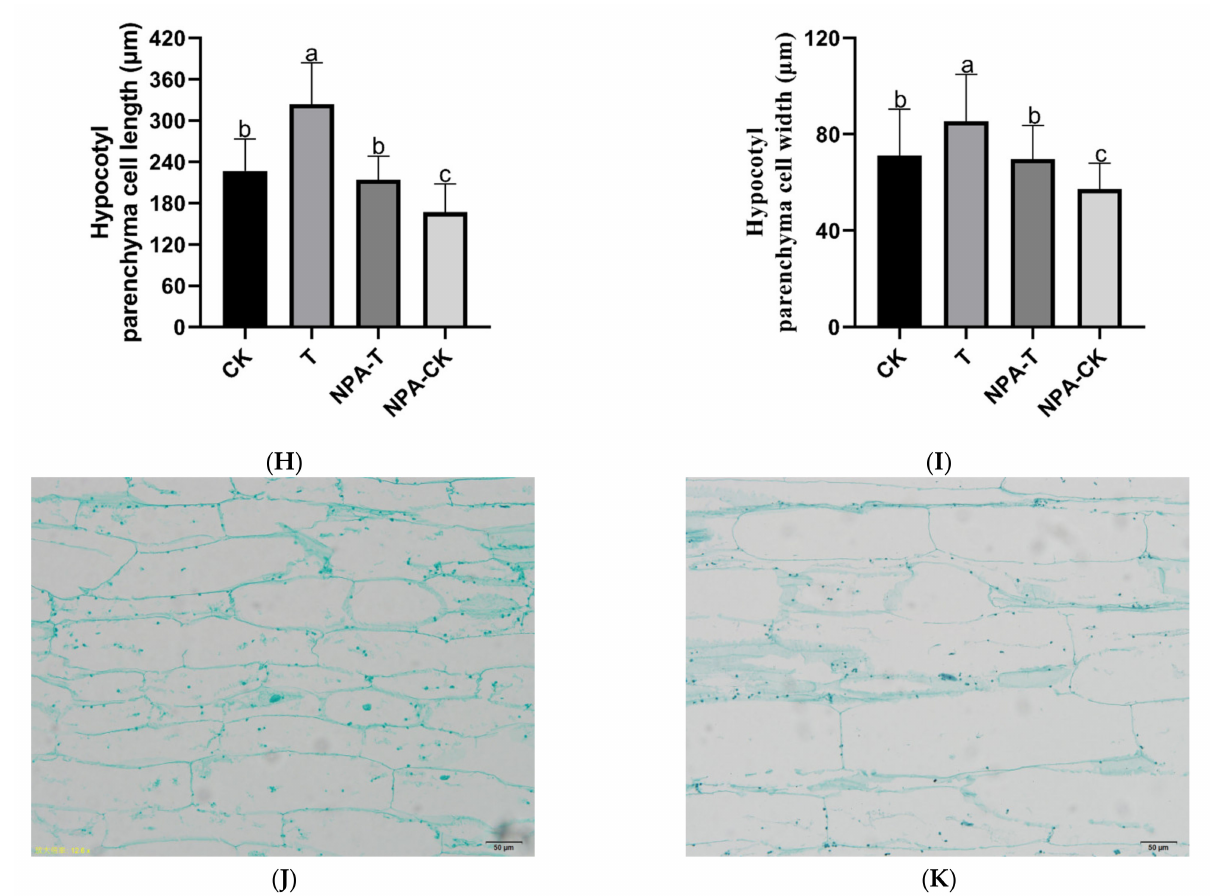
Figure 1. Phenotypic changes in pumpkin seedlings in response to EOD-FR treatment. CK, Control; T, EOD-FR treatment; NPA-T, EOD-FR treatment plus the auxin transport inhibitor NPA; NPA-CK, NPA alone. ( A ) Pumpkin seedlings from different treatments. Hypocotyl length ( B ), stem diameter ( C ), shoot system fresh weight ( D ), root fresh weight ( E ), shoot system dry weight ( F ), and root dry weight ( G ) of pumpkin seedlings from different treatments. Observations of hypocotyl cells in pumpkin seedlings during EOD-FR treatment. Changes in length ( H ) and width ( I ) of parenchyma cells in different treatments. Morphological changes in hypocotyl cells of different treatments ( J , K ). Different lowercase letters denote significant differences ( p < 0.05), and error bars indicate SD